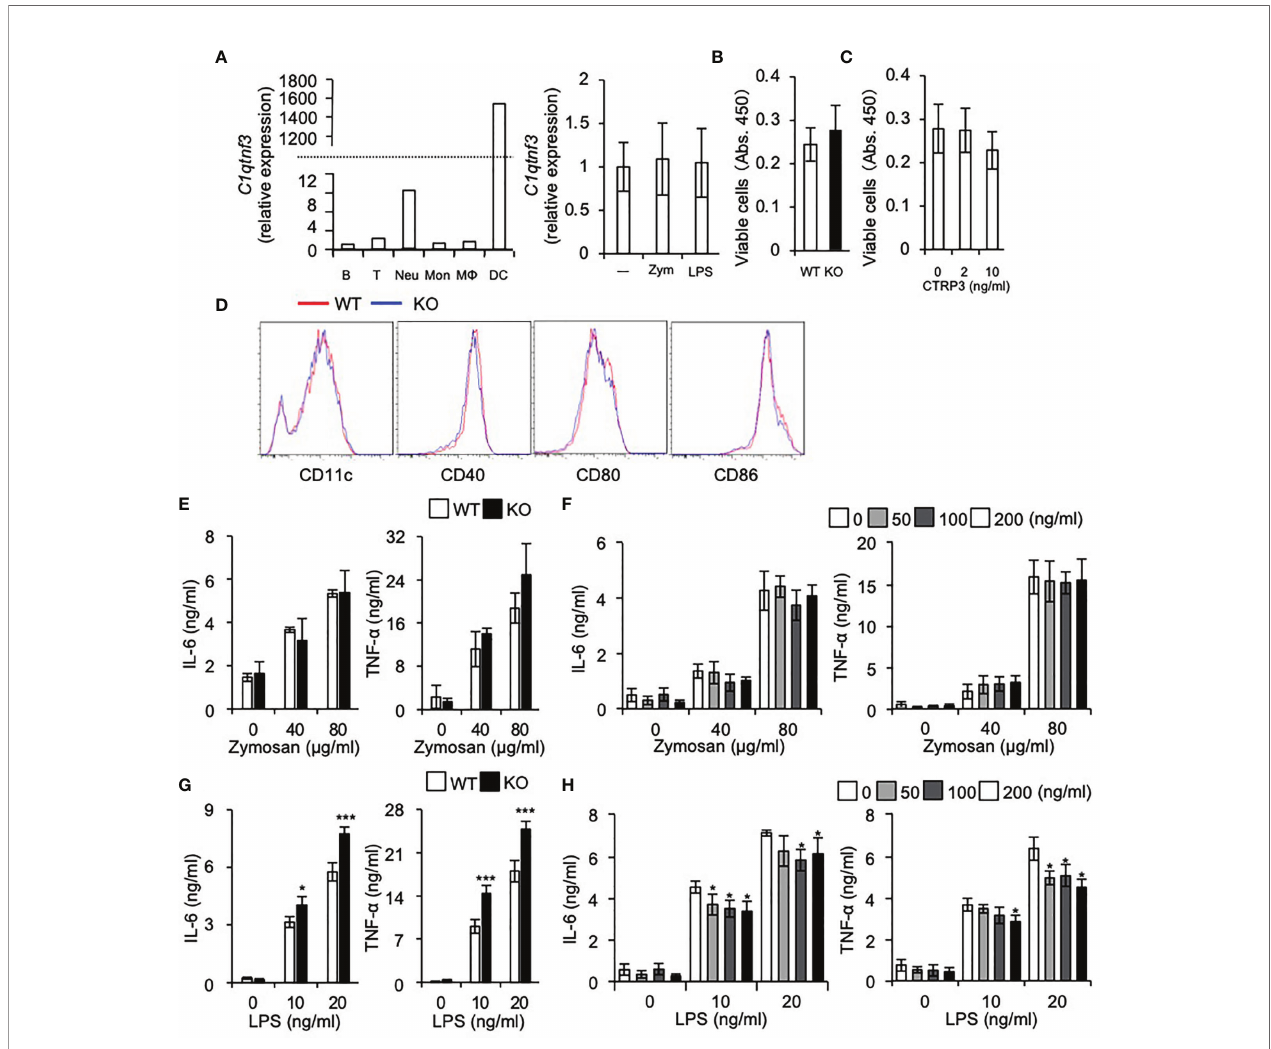
FIGURE 4 | DC differentiation is normal in C1qtnf3 -/- mice. (A) C1qtnf3 mRNA in immune cells was determined by real-time PCR, and the relative expression levels to that in B cells are shown in left panel. C1qtnf3 mRNA expression in DCs after stimulation with zymosan or LPS was determined by real-time PCR, and the relative expression levels to that in cells without stimulation (-) are shown in right panel. (B, C) Effect of CTRP3 on the differentiation and proliferation of BMDCs. BMDCs were differentiated from WT or C1qtnf3 – / – (KO) BMCs (B) , or from C1qtnf3 – / – BMCs in the presence of indicated concentrations of CTRP3 (C) . Then, viable cell number was counted at day 8 by using Cell Counting Kit-8. 4 wells for each. Average and SEM are shown. Student ’ s t -test. (D) WT or C1qtnf3 -/- (KO) BMCs were cultured under BMDC-differentiation conditions, and the expression of CD11c, CD40, CD80 and CD88 was determined by fl ow cytometry at day 8. (E) IL-6 and TNF- a concentration in the culture supernatant of WT or C1qtnf3 – / – (KO) BMDCs were measured by ELISA after stimulated with zymosan (0, 40 and 80 m g/ml). Four wells for each. Average and SEM are shown. Student ’ s t -test. (F) IL-6 and TNF- a concentration in the culture supernatant of C1qtnf3 – / – BMDCs were measured by ELISA after stimulated with zymosan (0, 40 and 80 m g/ml) with/without CTRP3. Four wells for each. Average and SEM are shown. Student ’ s t -test. (G) IL-6 and TNF- a concentration in the culture supernatant of WT or C1qtnf3 – / – (KO) BMDCs were measured by ELISA after stimulated with LPS (0, 10 and 20 ng/ml). Four wells for each. Average and SEM are shown. * p < 0.05, *** p < 0.001. Student ’ s t -test. (H) IL-6 and TNF- a concentration in the culture supernatant of C1qtnf3 – / – BMDCs were measured by ELISA after stimulated with LPS (0, 10 and 20 ng/ml) with/without CTRP3. Four wells for each. Average and SEM are shown. * p < 0.05. Student ’ s t -test. All data were reproduced in another independent experiment with similar